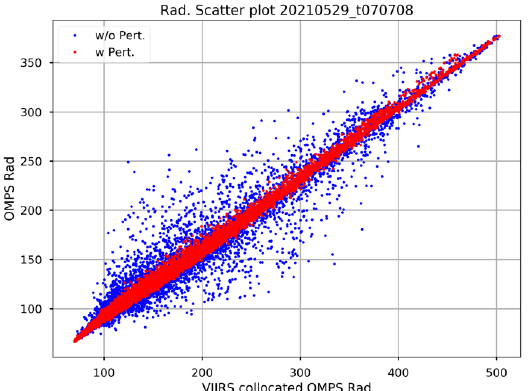
Figure 5. Scatter plot between real and VIIRS-collocated OMPS-NM radiances. The blue dots indicate the VIIRS-collocated OMPS-NM radiances using the original OMPS geolocation fields, while the red dots are perfectly aligned with the VIIRS. The radiance unit is W/(cm 3 Sr).